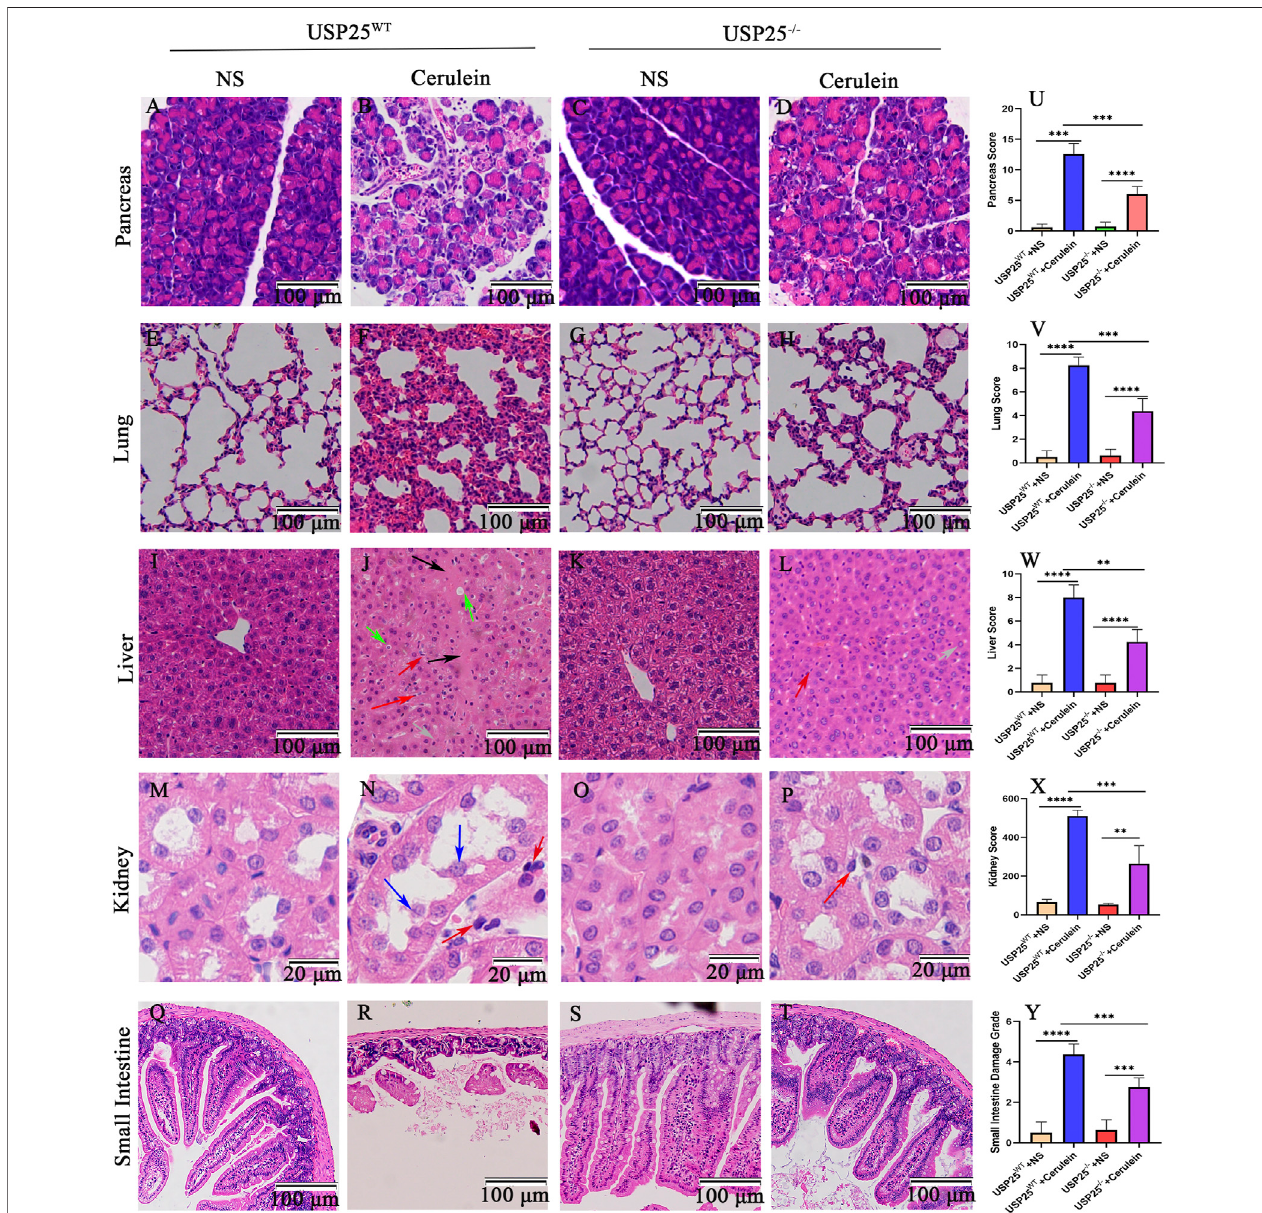
FIGURE 3 | USP25 de fi ciency attenuates pancreatic in fl ammation and AP-related multiple organ injury in vivo . USP25 Wild − Type (WT) mice and USP25 knockout (USP25 − / − ) mice were randomly divided into four groups (n (cid:1) 8 per group): USP25 WT + NS, USP25 WT + cerulein, USP25 − / − + NS, USP25 − / − + cerulein. (A – T) H&E staining of pancreas, lung, liver, kidney, and small intestine in four experimental groups (Black arrow: necrosis; red arrow: in fl ammatory cell; green arrow: cytoplasmic vacuolation; grey arrow: edema; blue arrow: detachment of tubular epithelial cell). (U – Y) The histological scores of pancreas, lung, liver, kidney, and small intestine in four experimental groups. ** p < 0.01, *** p < 0.001 and **** p < 0.0001.